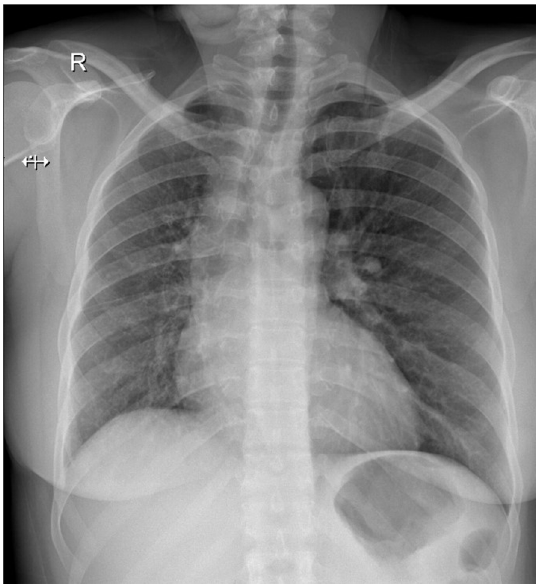
Fig. 1 Radiograph chest PA view showing smaller right hemithorax, with mild tracheal and mediastinal deviation to right and elevation of hemidiaphragm. Mild diffuse haziness and decreased vascular markings over right lung zones. The right hilum is not well visualized